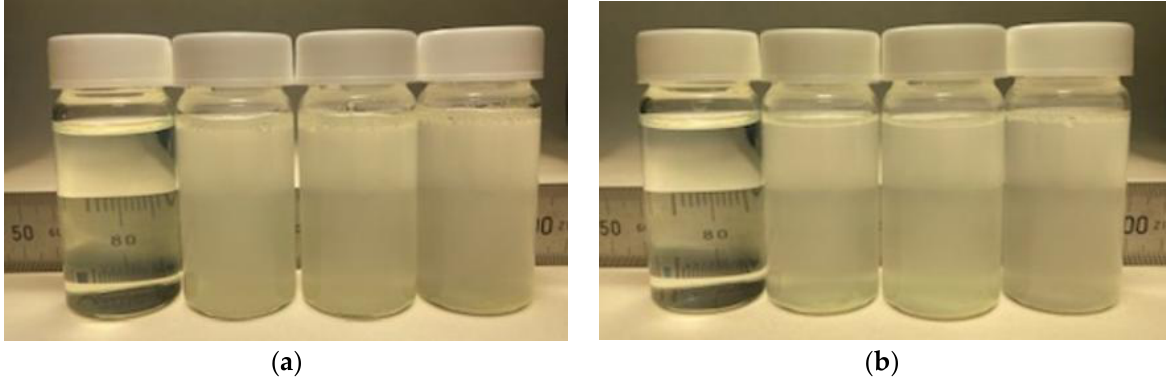
Figure 3. From left to right: ( a ) BL-03 aqueous solution from DEG solution (reference), BL-03 in 0.3% DEG aqueous solution, BL-03 in 0.5% DEG aqueous solution, BL-03 in 0.9% DEG aqueous solution; ( b ) BL-05 aqueous solution from DEG solution (reference), BL-05 in 0.3% DEG aqueous solution, BL-05 in 0.5% DEG aqueous solution, BL-05 in 0.9% DEG aqueous solution.